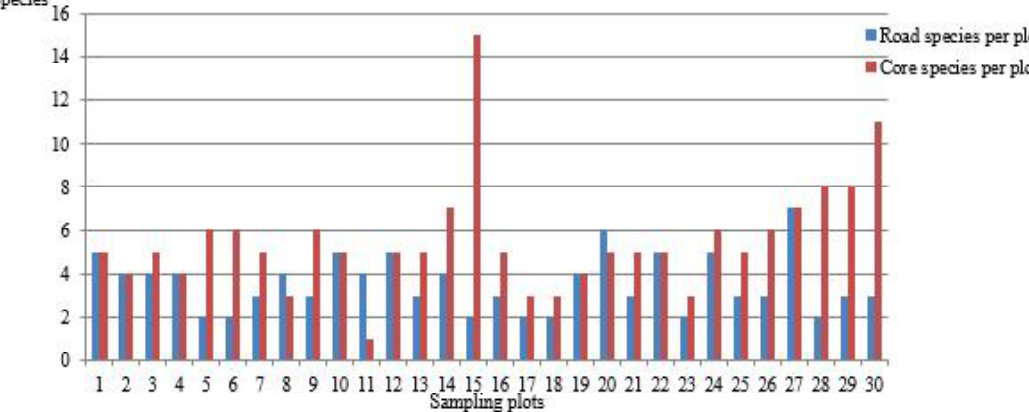
Fig. 3: Variation of insect species richness at each plot from the road verge (red) and from the core area (blue)